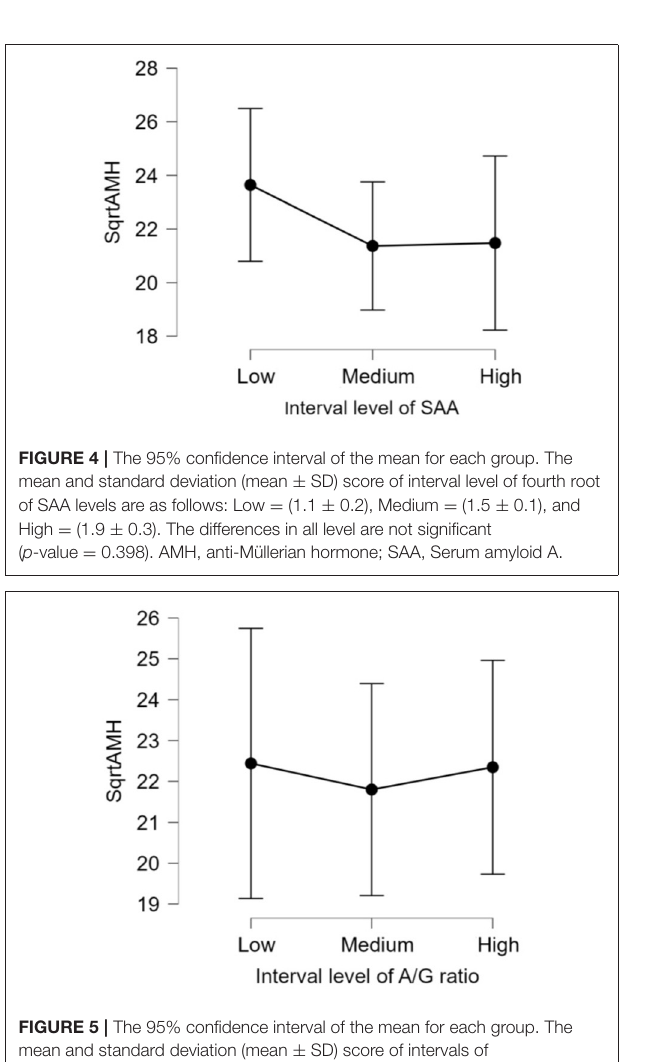
biomarkers, such as AFC or AMH, is now applied in